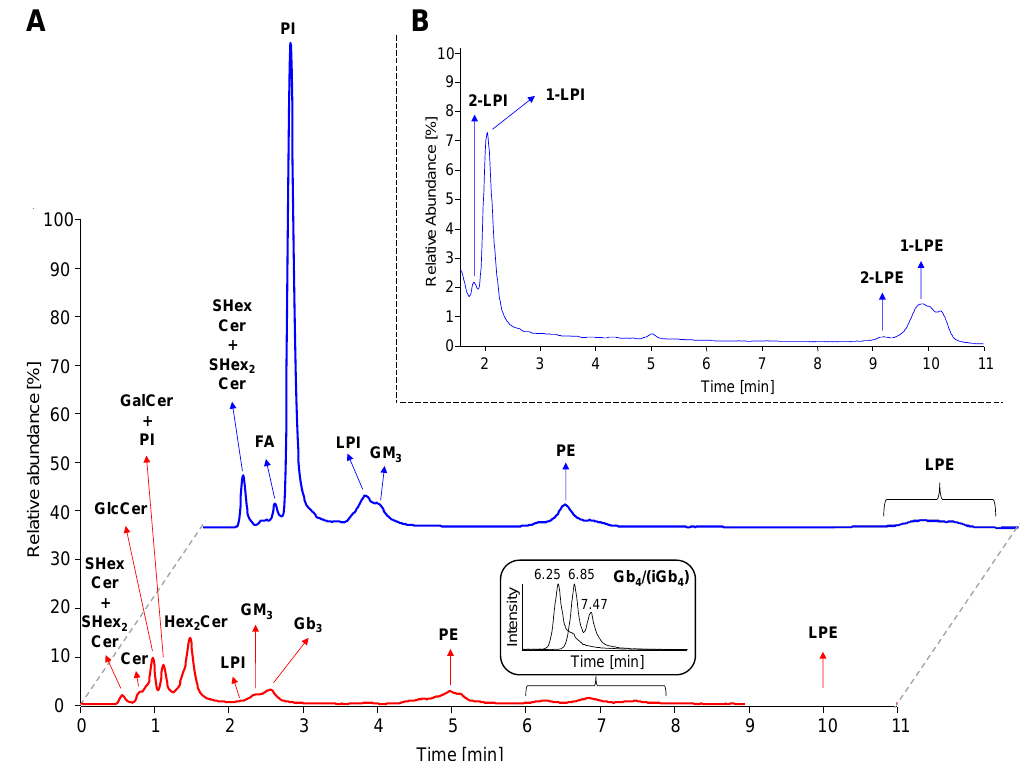
Figure 4. Hydrophilic interaction liquid chromatography coupled to electrospray ionization mass spectrometry ( HILIC- ESI/MS) chromatograms. ( A ) Reconstructed ion current (RIC) chromatograms of detected lipid subclasses ( m/z 50–1500) in human plasma using both positive (bottom red line) and negative (upper blue line) polarity modes. ( B ) Chromatogram illustrating separation of sn -1 (i.e., 1-LPI and 1-LPE) and sn -2 (i.e., 2-LPI and 2-LPE) regioisomers of lysophospholipids. Abbreviations: (lyso)phosphatidylinositols, (L)PI; (lyso)phosphatidylethanolamines, (L)PE; isoglobotetraosylceramides